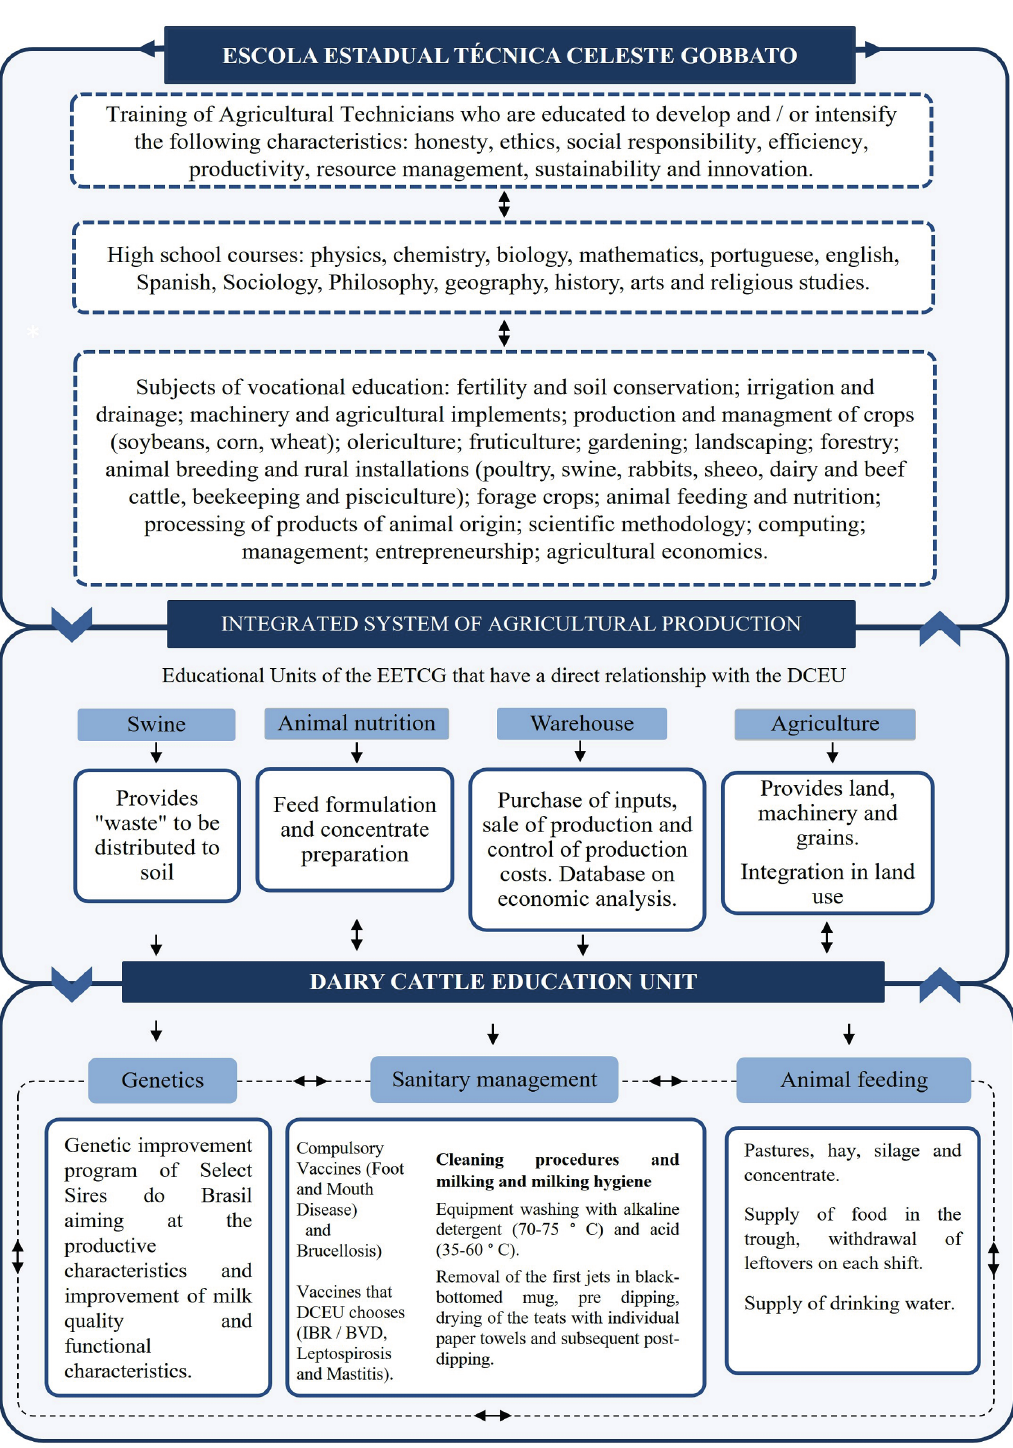
Figure 1 - Summarized graphic representation on the activities of the Escola Estadual Técnica Celeste Gobbato with emphasis on the activities of the Dairy Cattle Education